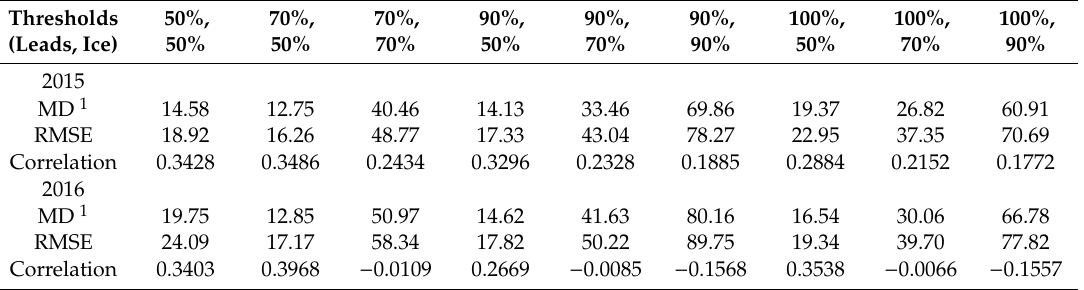
Table 7. Retrieved sea ice freeboard using BCF with di ff erent retracking thresholds relative to the freeboard determined from OIB data acquired in March 2015 and April